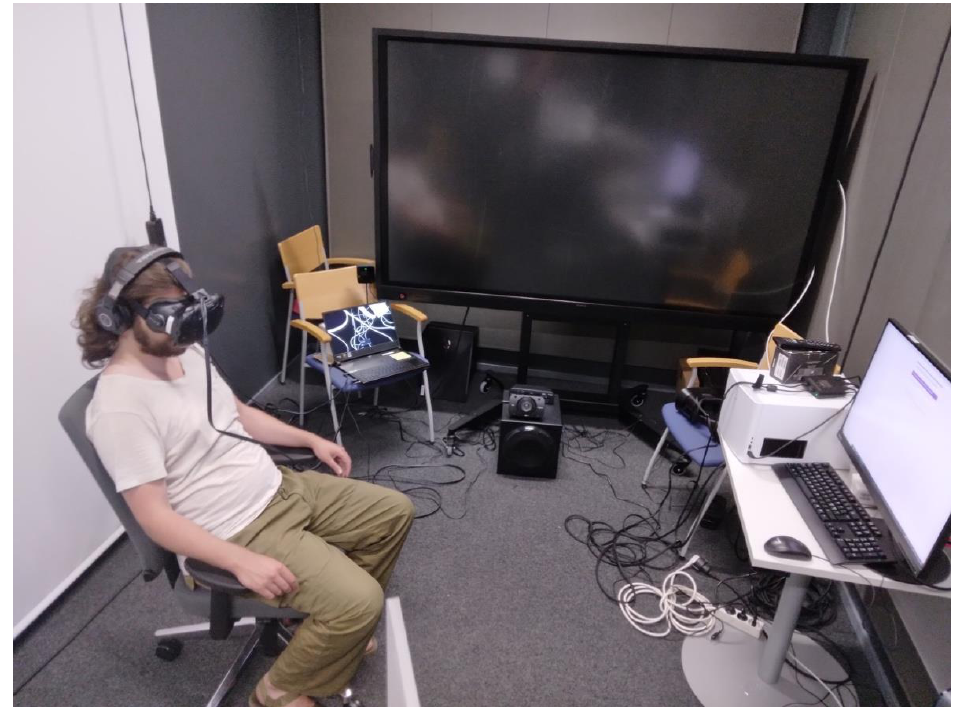
Figure 2. Test participant using Binaural Odyssey during the experimental research. The computer on the right side of the picture was used for digital